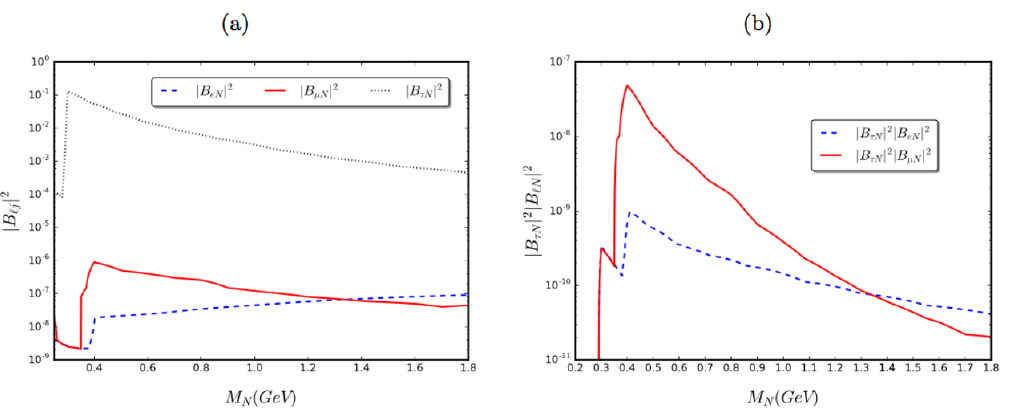
Figure 7 . (a) Exclusion regions of j B ‘N j 2 taken from [26]. The dotted line (online black) stand for j B (cid:28)N j 2 , solid line (online red) stand for j B (cid:22)N j 2 and the dashed one (online blue) for j B eN j 2 . (b): exclusion regions for the product of heavy-light mixings j B (cid:28)N j 2 j B ‘N j 2 . The dashed line (online blue) stand for j B (cid:28)N j 2 j B eN j 2 and the solid one (online red) for j B (cid:28)N j 2 j B (cid:22)N j 2